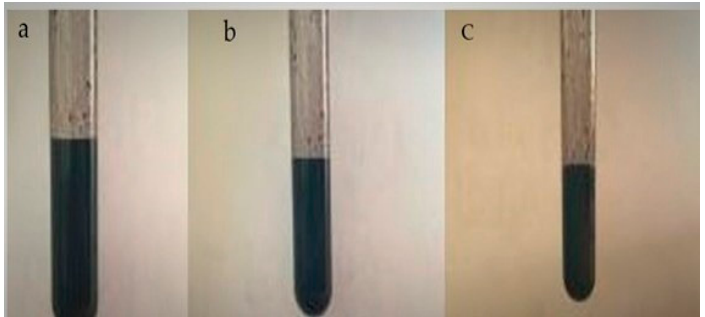
Figure 1. Photographs of the dispersion of the charcoal particles after ( a ) a week; ( b ) two weeks and ( c ) a month.